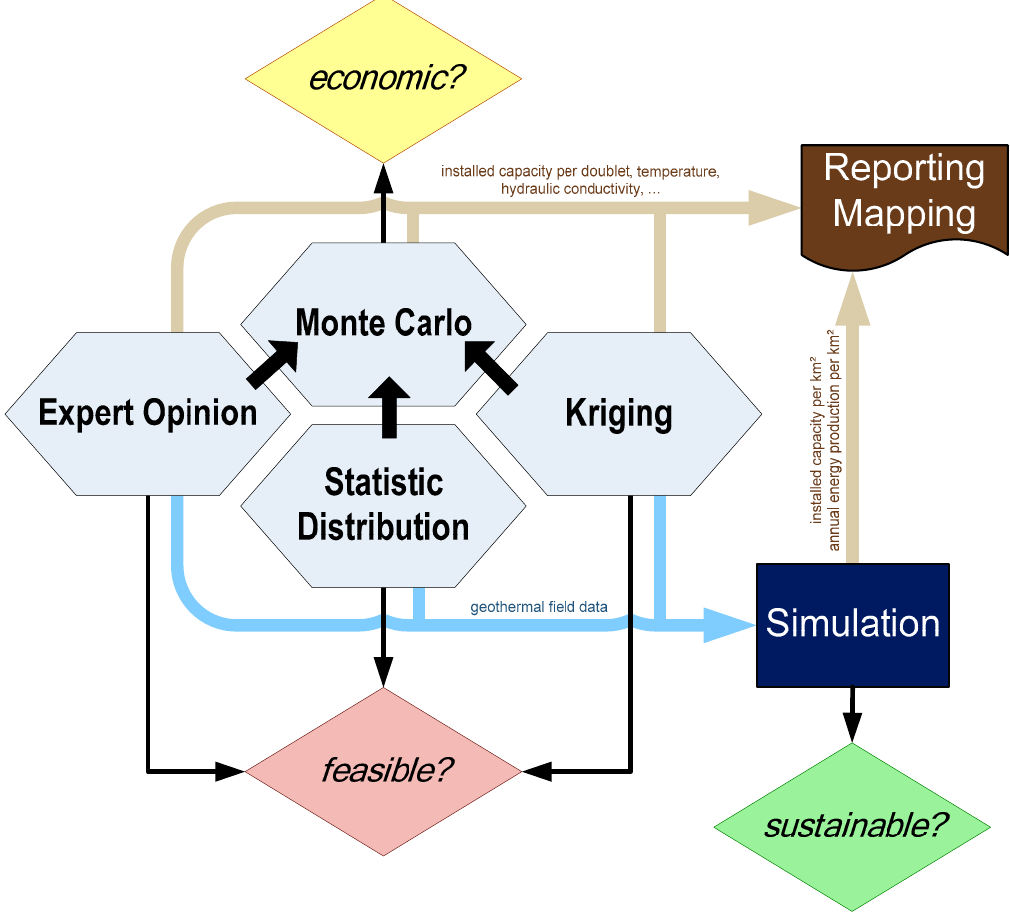
Figure 2. Statistic tools, methods, criteria, and workflows for geothermal resource and reserve assessment in Germany. Starting points are predictions of relevant parameters based on available data (pale blue hexagons). Expert opinion and Monte Carlo simulations can be used for mapping. Simulation models can be conducted for assessing output over time of single sites.